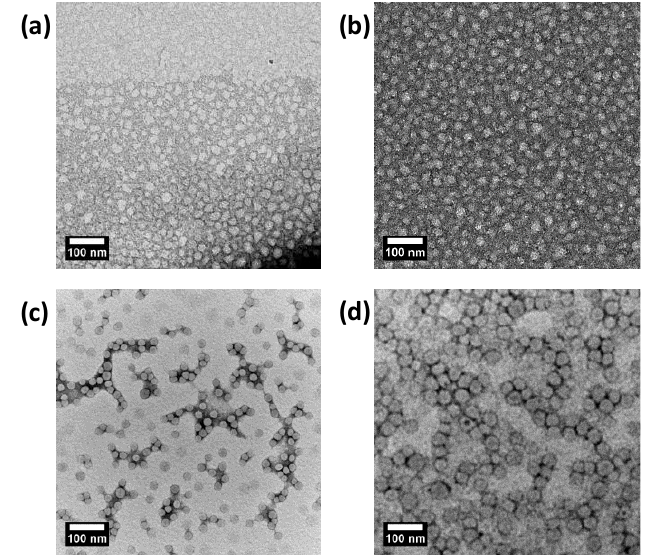
Figure 4. TEM images from water suspensions of: ( a ) PAMAM32-ChCou, ( b ) PAMAM64-ChCou, ( c ) PAMAM16- cov -ChCou and ( d ) PAMAM64- cov -ChCou.